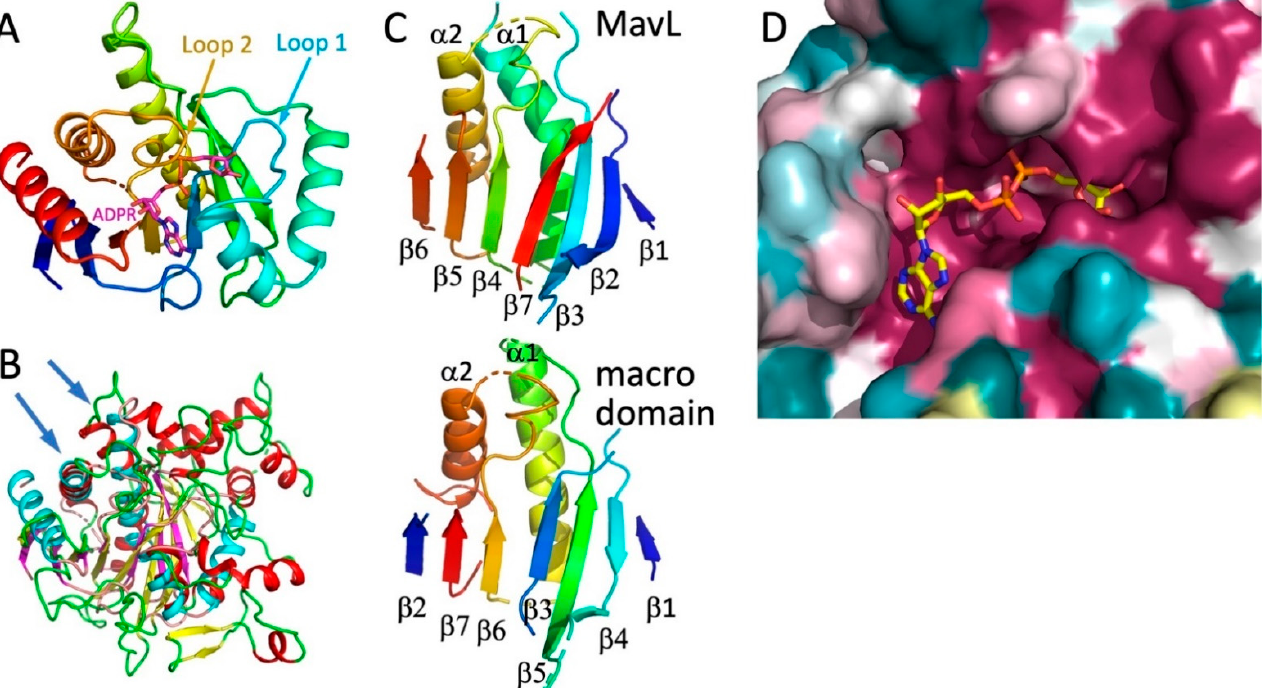
Figure 4. Comparison of MavL with macrodomains. ( A ) The compact macrodomain, PARP14 (ARTD8) macrodomain 1, with bound ADP-ribose (PDB ID 3Q6Z). This macrodomain has an additional N-terminal β -strand relative to the minimal fold. ( B ) Superposition of MavL and T. curvata macrodomain (PDB ID 3SIG), showing overlap of β -sheets and two long α -helices (marked by arrows). In MavL, β -strands are yellow, helices are red, and loops are green, while in the macrodomain, β -strands are magenta, helices are cyan, and loops are salmon. ( C ) While the secondary structural elements assume similar spatial positions in MavL and the T. curvata macrodomain, their connectivity is quite different. The secondary structures in both proteins are rainbow-coloured from blue at the N-terminus to red at the C-terminus. ( D ) The closeup of the cavity in the MavL structure as shown in panel 3B. The structure of Tetrahymena thermophila macrodomain (PDB ID 4EPP) was optimally superimposed on MavL, showing that the ADP-ribose bound to the macrodomain fits very snugly into a deep depression in the MavL surface formed by highly conserved residues.